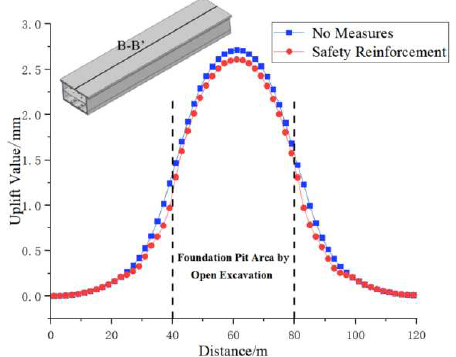
Figure 17. Longitudinal uplift contrast curves of existing stations.